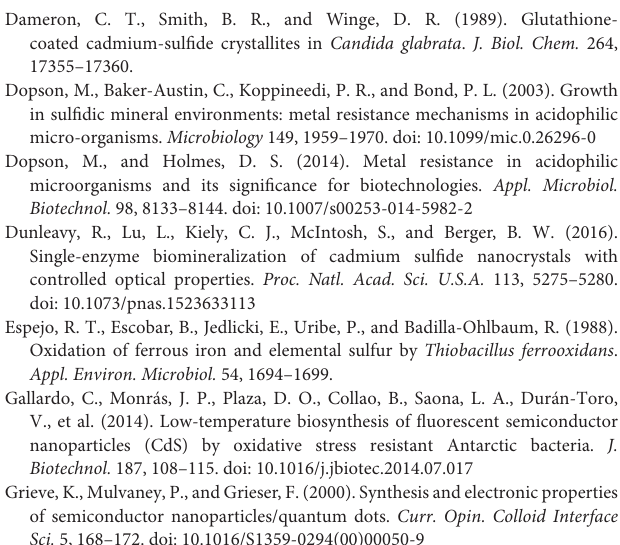
Table S1 | RSM experimental conditions. Two experimental conditions were used for RSM construction; MIC conditions and Biosynthesis conditions. The nine coded conditions used and the corresponding values of variables for the two experimental conditions are indicated. The biosynthesis of NPs was evaluated in supernatants of cell cultures exposed 24h to the indicated Cd 2 + and PO 3 − 4 concentrations at pH 3.5. Rows 4 and 9 (highlighted) correspond to those experimental conditions in which size and composition of biosynthesized QDs were characterized by TEM and EDS, respectively ( Figure S1